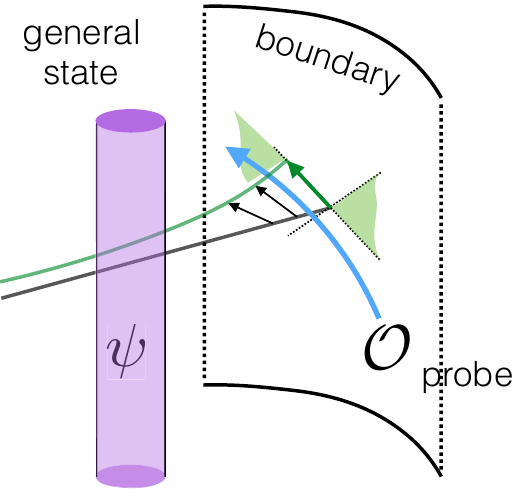
Figure 2 . A schematic of the AdS/CFT setup for understanding f ( s ). The lightcone limit of a four point function ψ ψ can be interpreted in terms of a dual holographic setup where the (cid:31) OO (cid:29) dual particle excitation to and ψ stay far away from each other in AdS space by having a large O relative angular momentum. We use this setup as inspiration for our computation, where we add into the mix two entangling surfaces which start null separated at the boundary and fall into the bulk. EWN is the statement that these surfaces should be spacelike separated as one moves into the bulk. The particle in the high energy/lightcone limit probes these entangling surfaces near O the boundary after we act with modular flow on this